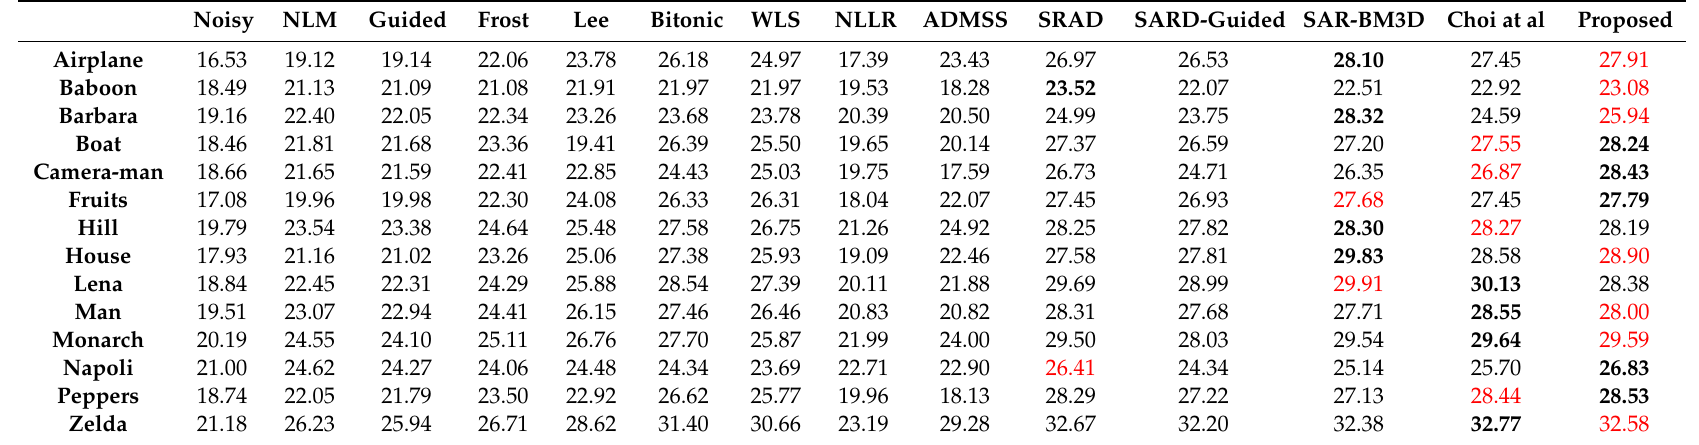
Table 4. Peak signal-to-noise (PSNR) (in dB) results for each standard image (The best value is shown in bold and the second-best value is shown in red color). Noisy NLM Guided Frost Lee Bitonic WLS NLLR ADMSS SRAD SARD-Guided SAR-BM3D Choi at al Proposed Airplane